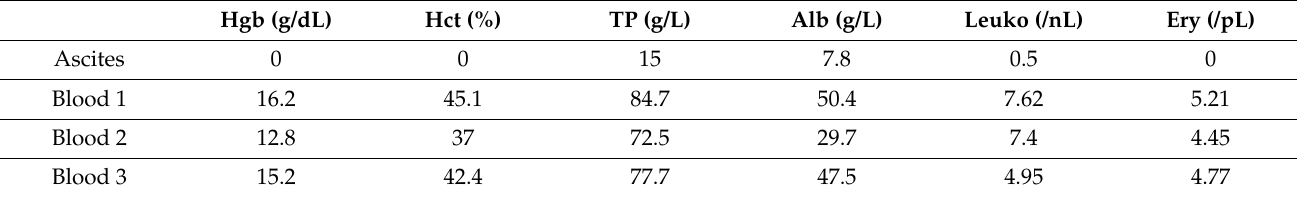
Table 1. Laboratory-chemical analysis of ascites and blood